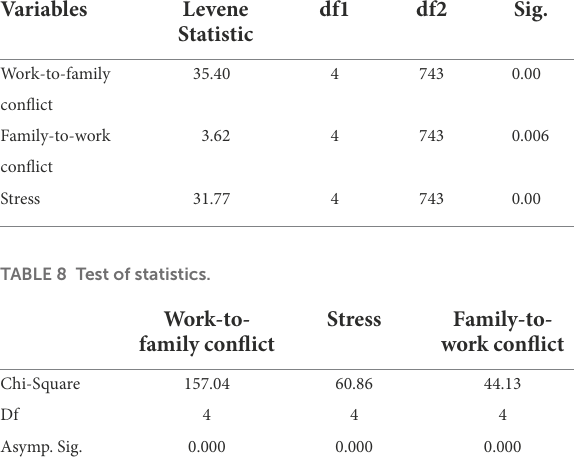
TABLE 7 Test of homogeneity of variances.